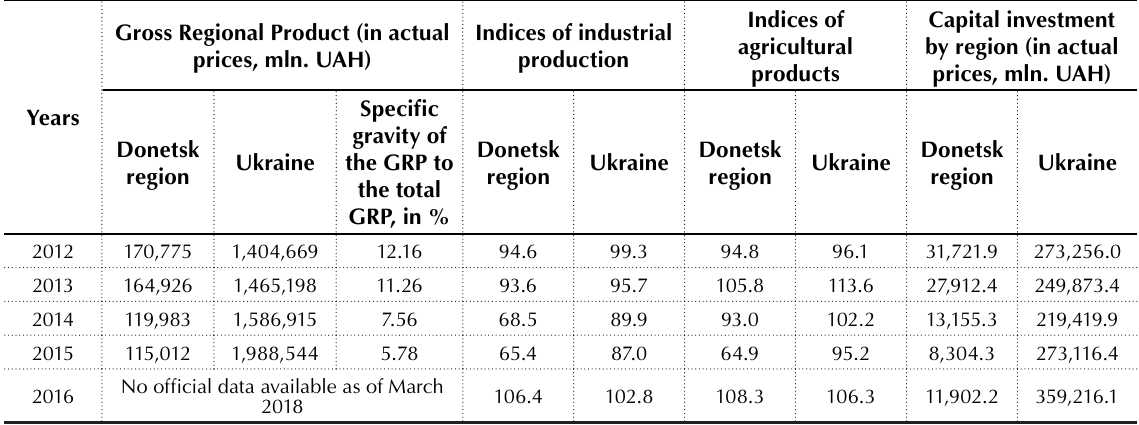
Table 2. Value of key indicators of the economic sphere